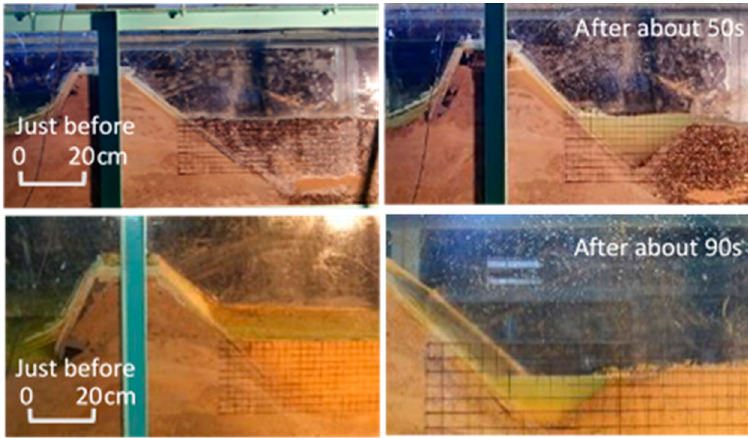
Figure 2. Experimental situation of scour in the dike’s land side.